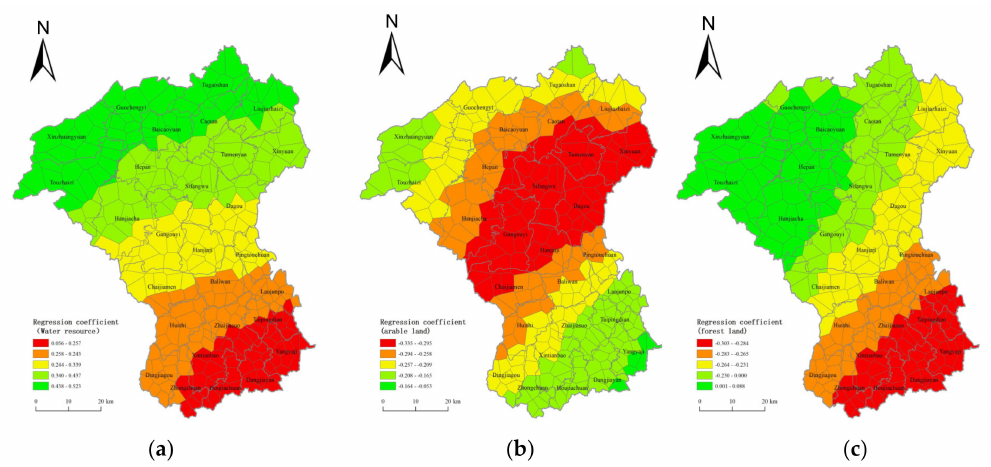
Figure 5. The GWR coe ffi cients between rural poverty and water resources and land resources in the GWR model: ( a ) water resource accessibility, ( b ) arable land use, and ( c ) forestland